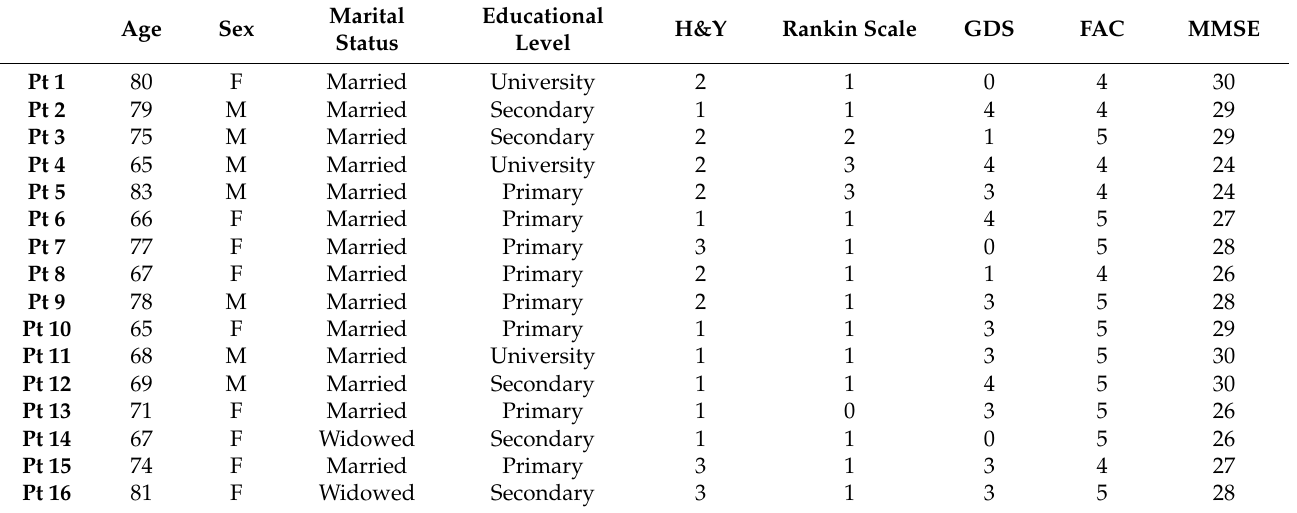
Table A1. Baseline Demographic and Clinical profile.